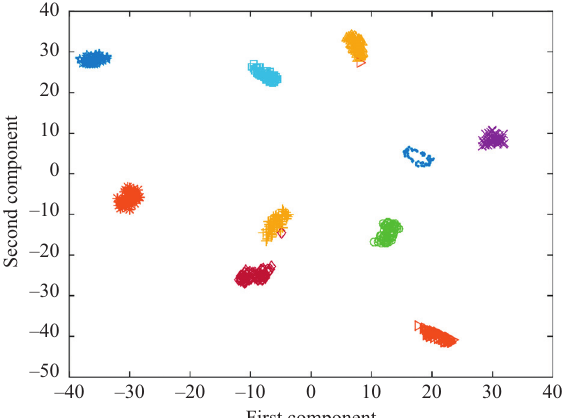
Figure 15: Visualization of 8% labeled